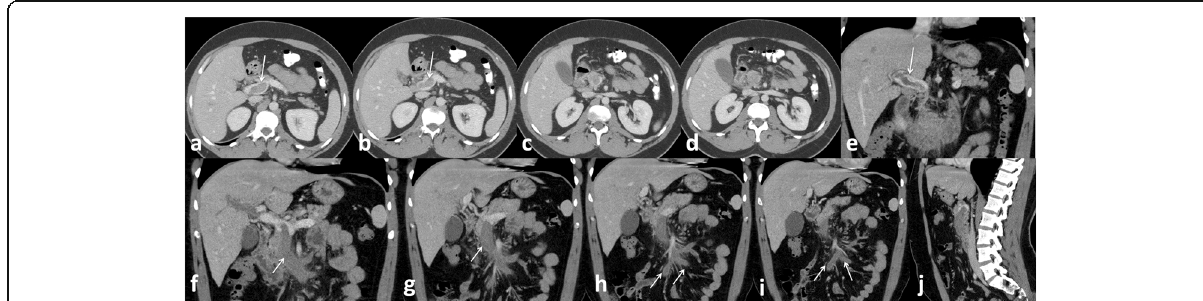
Fig. 13 Male patient 35 years old, Thrombosis of portal vein (white arrows in a , b , e ) extending into superior mesneteric vein ( arrows in f and g ) and its territories (arrows in h and i